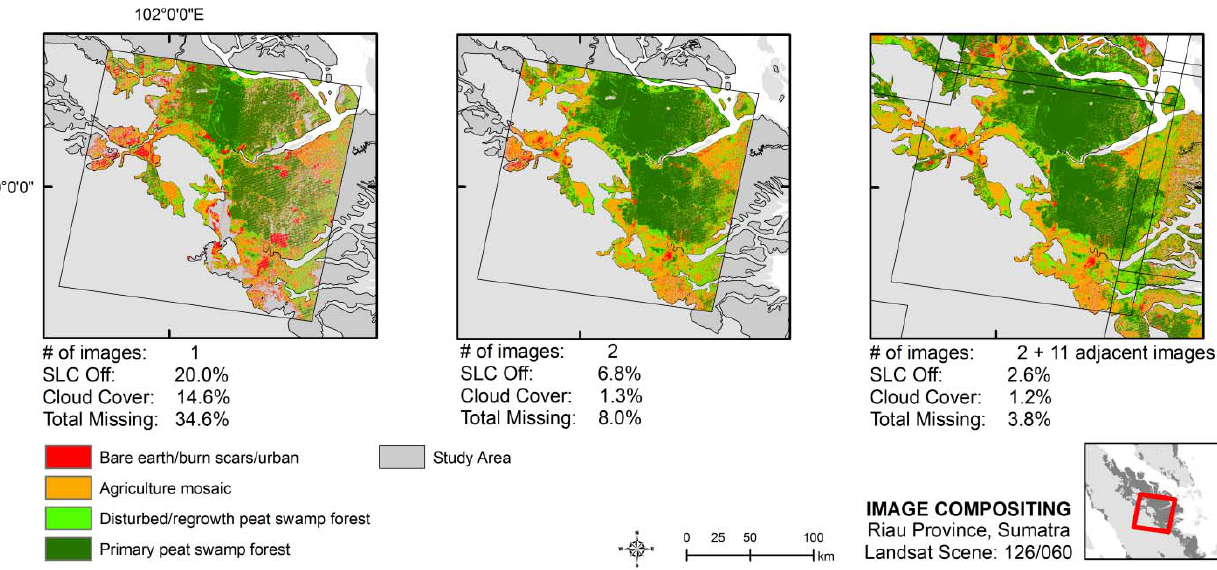
Figure A1. Spatial illustration of missing-data reduction per image when compositing two Landsat-7 SLC-Off images for scene 126/060 of the 2010 composite mosaic. Percentages reported are with respect to the study area, not the entire scene. The mapped area corresponds to Figure